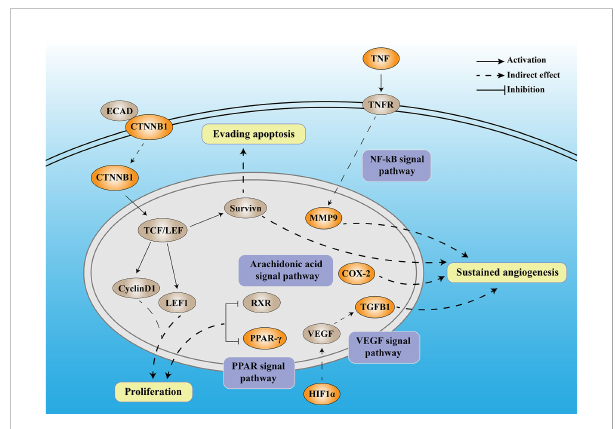
FIGURE 8 The mechanistic diagram of diabetes-based cancer-associated in fl ammation network (DCIN). The legend is included in the upper right corner of the image. The double-framed line in the upper part of the picture represents the cell membrane, and the double- framed line in the middle circle represents the nucleus. The orange gene represents the DCRGS screened out in this study, while the gray gene represents an important biological